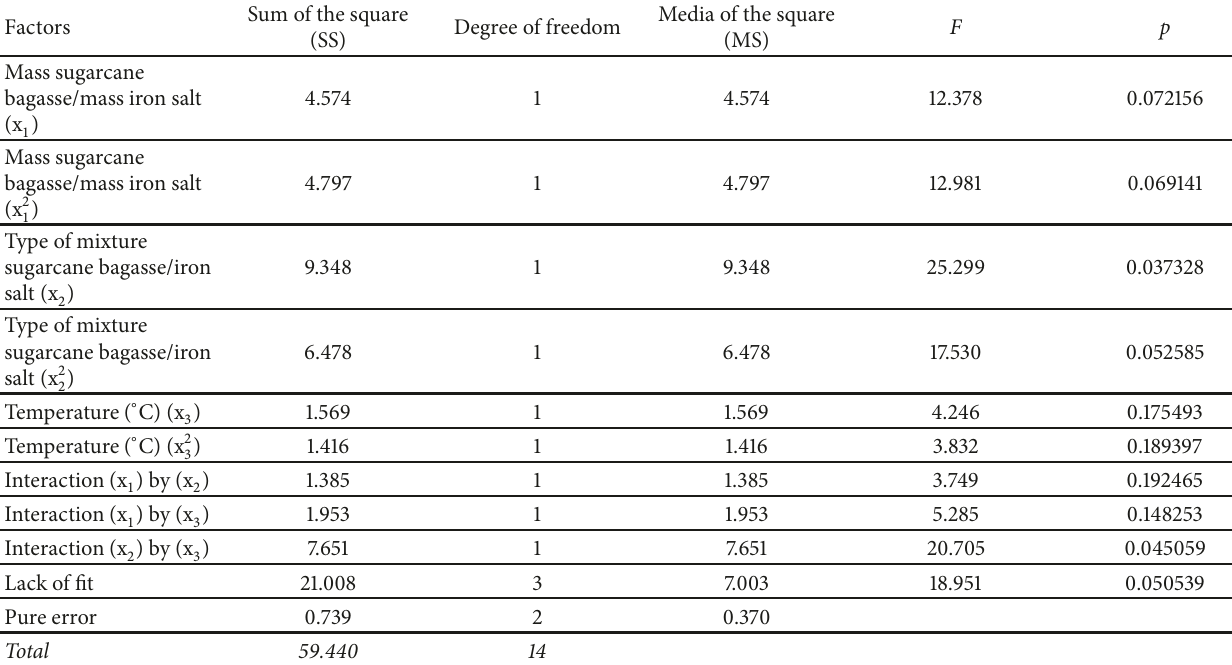
Table 4: Analysis of variance (ANOVA) for quadratic polynomial model for MB